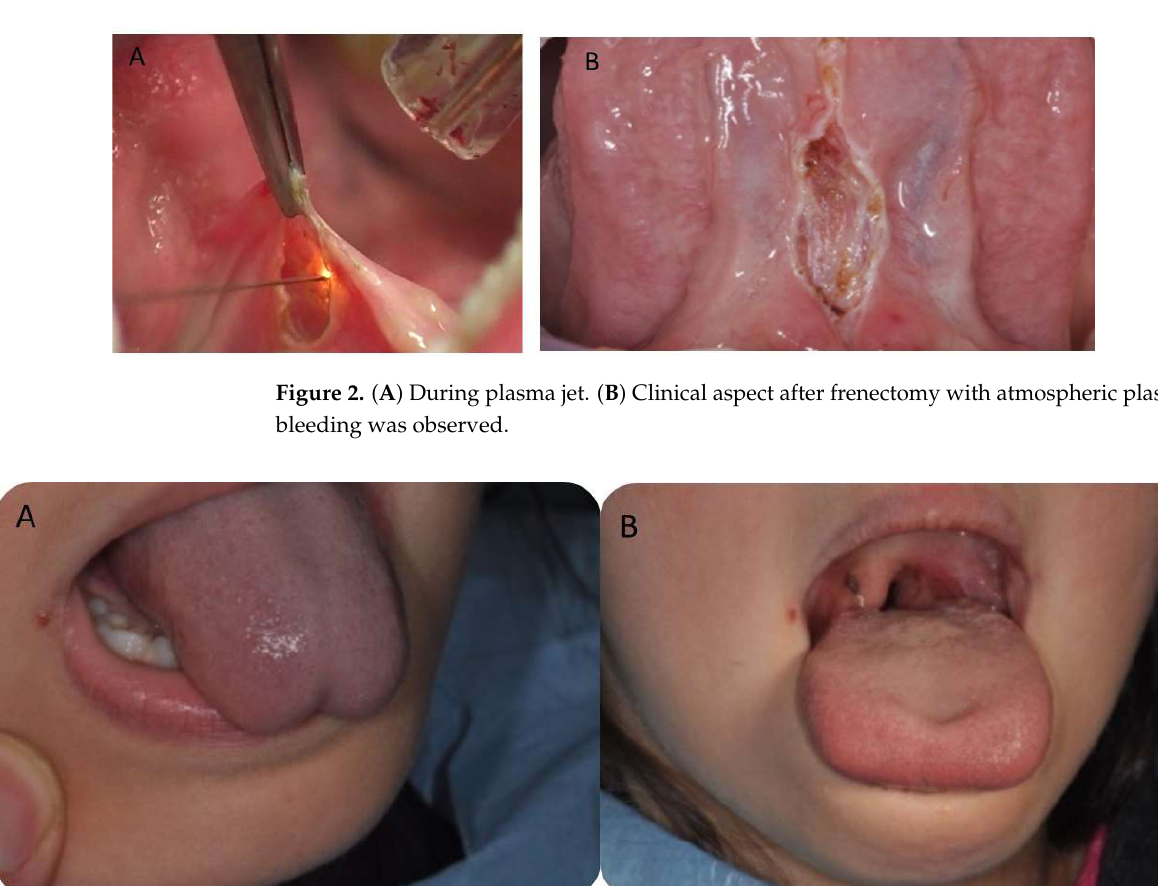
Figure 3. ( A ) Clinical aspect of the tongue is extremely limited before the treatment. ( B ) The mobility is visibly improved immediately post-treatment.